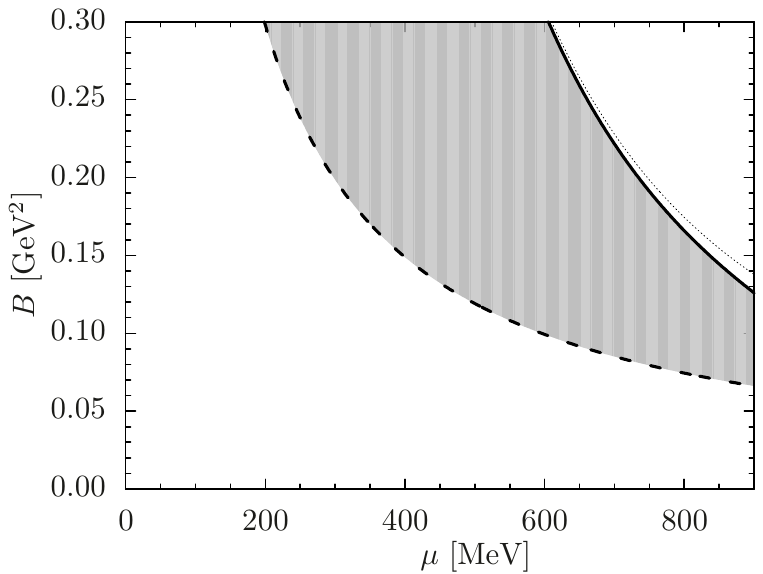
Figure 5 . The \phase diagram" of CSL as a function of chemical potential and magnetic (cid:12)eld. CSL becomes favored over the QCD vacuum above the critical (cid:12)eld B CSL (dashed line). For B (cid:21) B BEC , BEC of charged pions occurs (solid line). The dotted line stands for B BEC in the chiral limit (6.4). The shaded area indicates the region in which CSL of neutral pions can exist as the QCD ground state. The physical values f (cid:25) (cid:25) 92 MeV and m (cid:25) (cid:25) 140 MeV were used to obtain the numerical